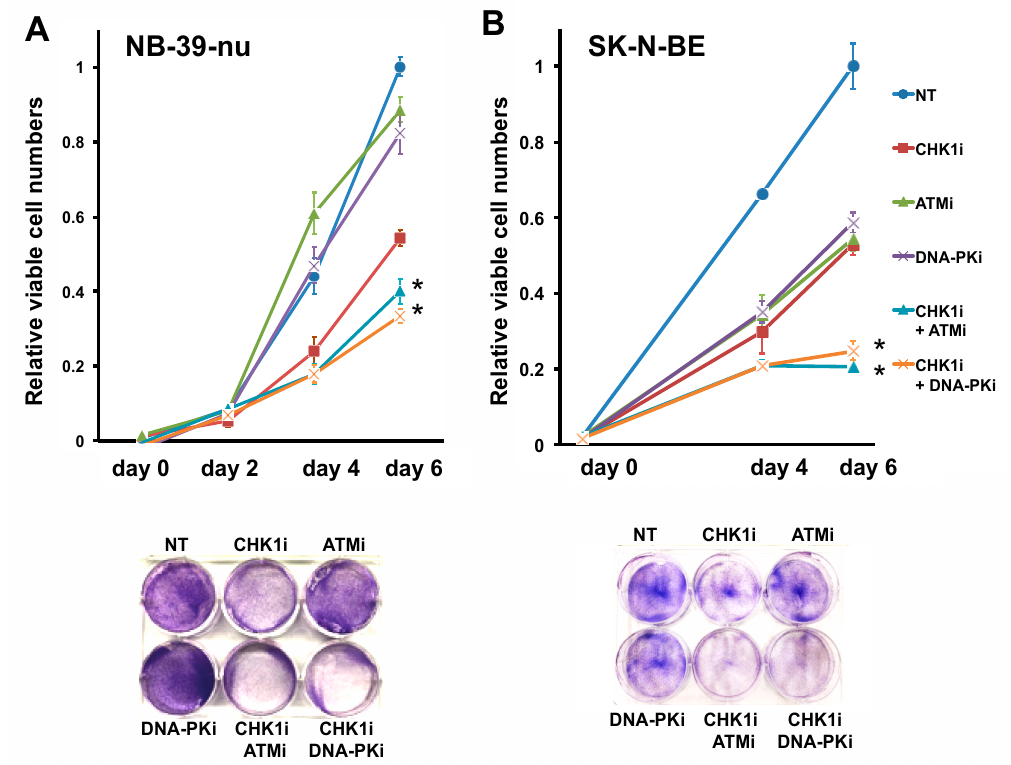
Figure 5. Combination treatment with either ATMi or DNA-PKi sensitizes NB cells to CHK1 inhibition. ( A ) CHK1i-insensitive NB-39-nu cells and ( B ) SK-N-BE cells were treated with DMSO (NT) or the indicated combinations of 0.175 µ M CHK1i (PF-477736), 10 µ M ATMi (Ku55933), and / or 1 µ M DNA-PKi (NU7441) for 6 days. At the indicated times, cells were harvested and analyzed for cell viability (upper panels) or Giemsa staining (lower panel). Data are presented as the mean ± SD of four independent experiments. * p < 0.05.